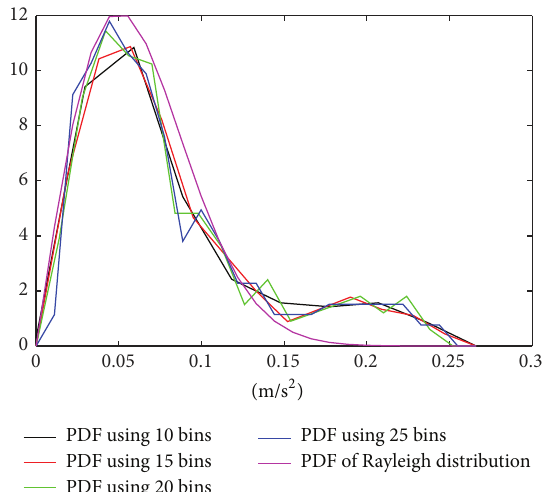
Figure 6: The iteration to determine 𝐿 and 𝐾 .